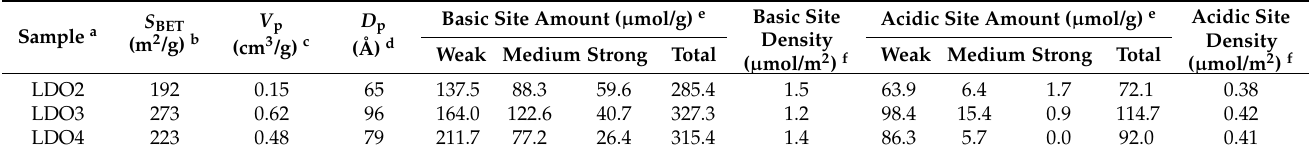
Table 1. Physicochemical properties of the calcined LDH samples.